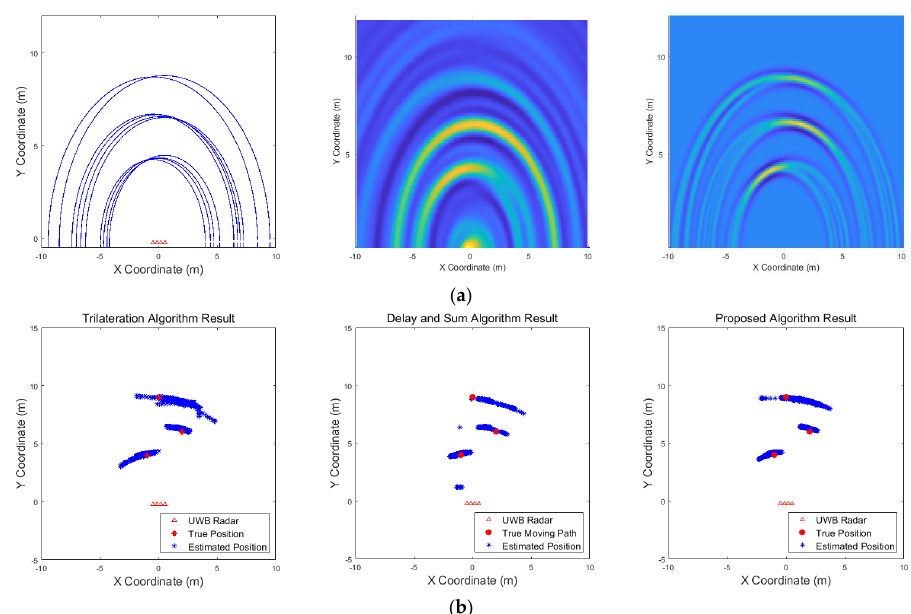
Figure 22. Experimental results when three targets stand behind the wall (Scenario 2): ( a ) instantaneous results of position estimation step according to the positioning algorithm; ( b ) results of the through-wall radar system.